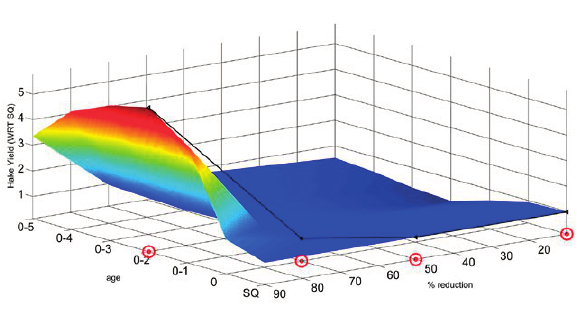
Fig. 4. - Impact on yield of hake in comparison with the status quo as age selectivity improves. Red labels show the optimal age range application for reductions of 90%, 70%, 50% and 10% in the selec- tivity parameters. The status quo (SQ) represents the situation with zero reduction in the selectivity